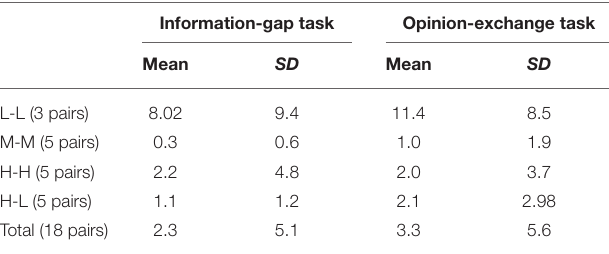
TABLE 5 | The percentage of L1 words per task type and proficiency